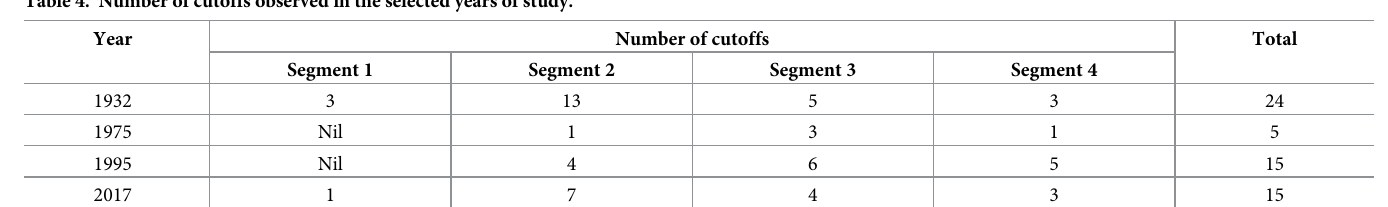
Table 4. Number of cutoffs observed in the selected years of study.